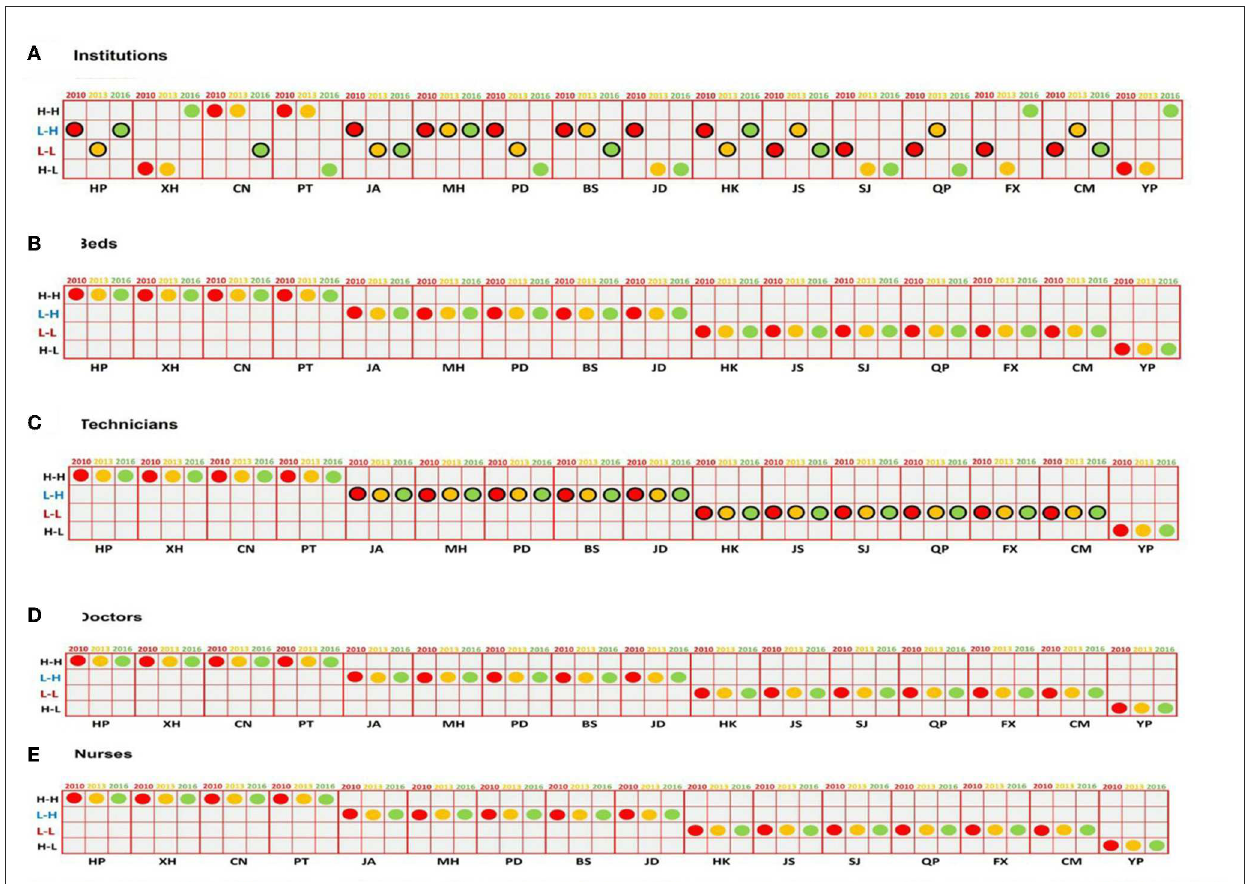
FIGURE2 Classification of four types of spatial autocorrelation for institutions (A) , beds (B) , technicians (C) , doctors (D) , and nurses (E) from 2010 to 2016.